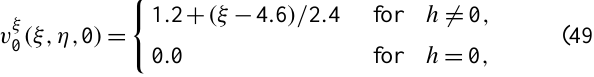
Fig. 3. Contour plots of the flowing mass and the evolution of the deposition heap, where Λ f = 0 and the deposition procedure is adopted in the computation.